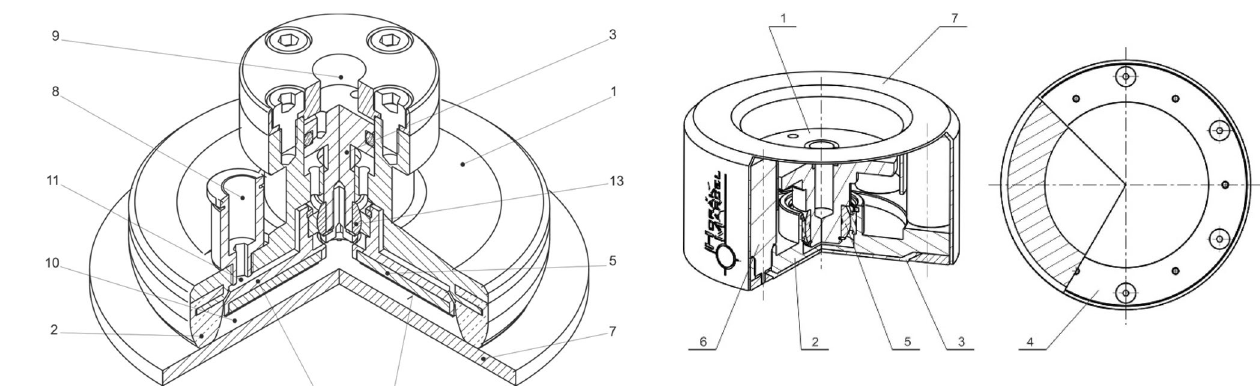
Fig. 28 Adhesive gripping element with an electromagnetic